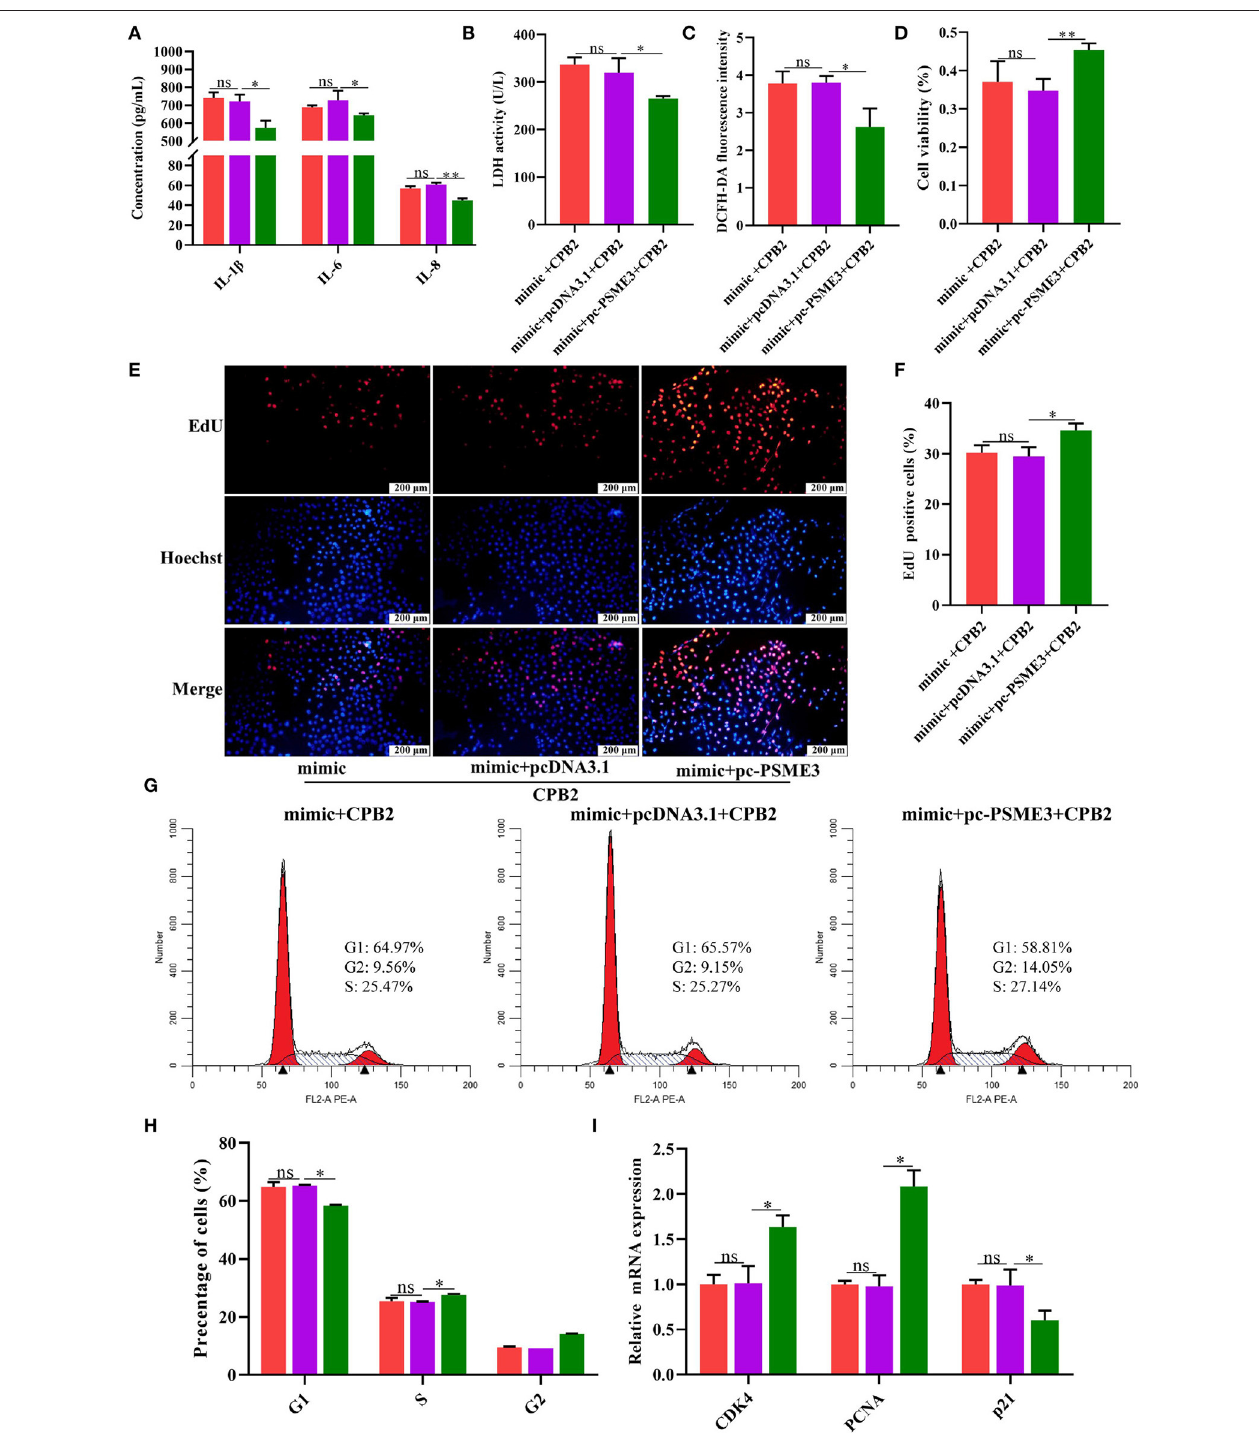
FIGURE 7 | PSME3 reversed the promotion of inflammatory damage by miR-30d in the IPEC-J2 cells. (A–I) The IPEC-J2 cells were co-transfected with the miR-30d mimic and the pc-PSME3 vector and treated with CPB2 toxin for 36h. (A) ELISA analysis of IL-1 β , IL-6, and IL-8 levels. (B) LDH activity was detected at 450nm in microplate reader. (C) The ROS level was detected by a microplate reader at 488-nm excitation wavelength and 535-nm emission wavelength. (D) Cell viability via CCK-8. (E) The EdU assay was performed. The IPEC-J2 cells in S-phase were stained red with EdU, whereas the nucleus was dyed blue with Hoechst. (F) Image J analysis of the proportion of proliferating cells. (G,H) Flow cytometry evaluated the cell cycle. (I) qPCR analysis of CDK4 , PCNA , and p21 expression. ns, not significant,* p < 0.05, ** p < 0.01.